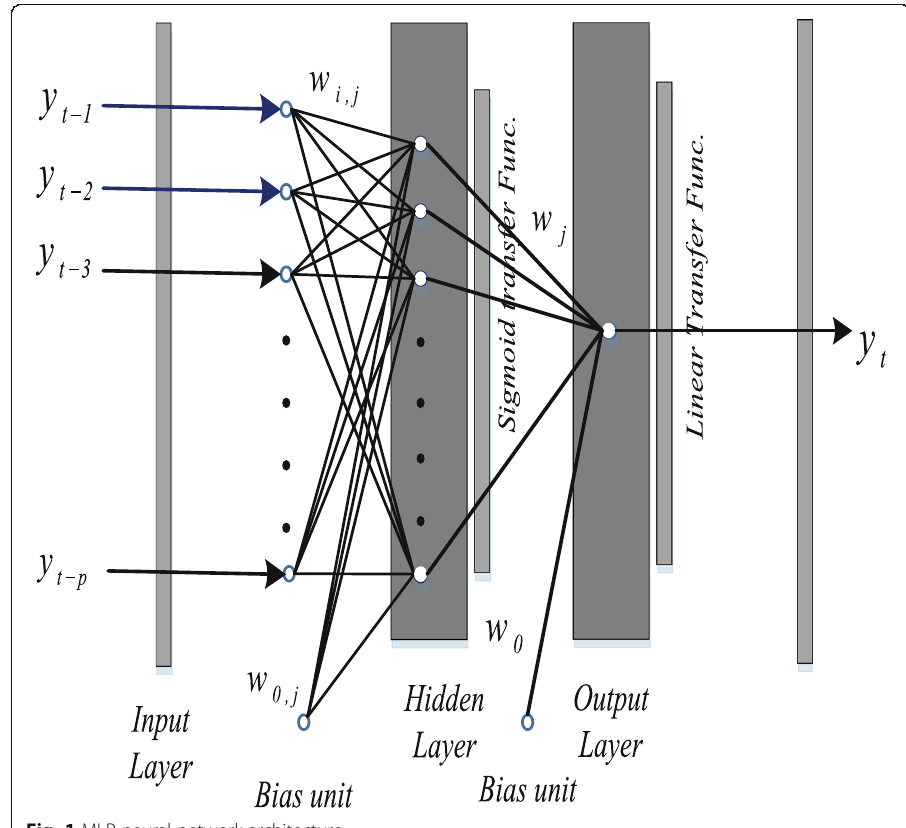
Fig. 1 MLP neural network